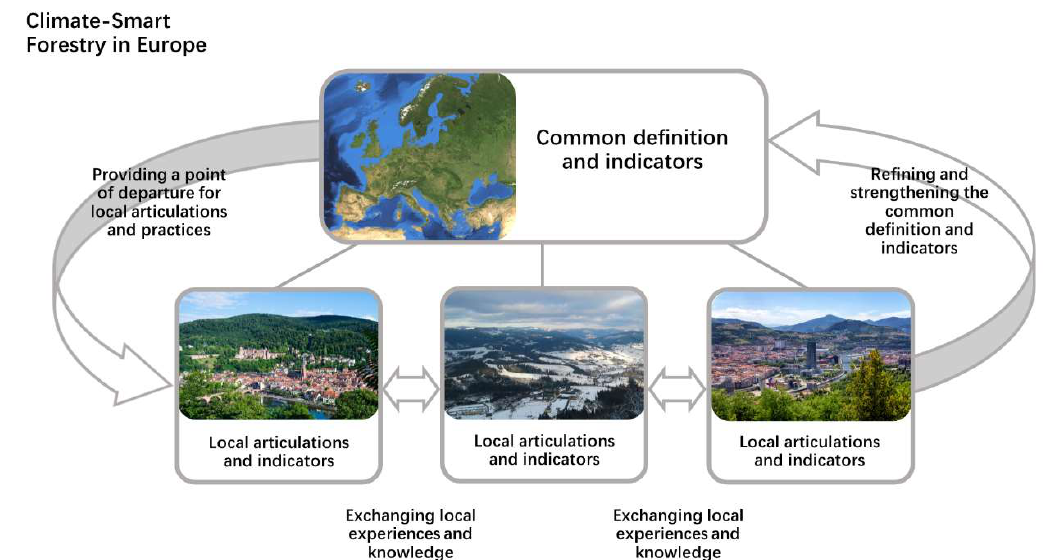
Figure 3. A conceptual figure for how the concept of climate-smart forestry could be used and developed in Europe. The message convened is that a meta-level scientific discussion on common indicators and definitions for climate-smart forestry needs to connect to local articulations and indicators to become applicable in practice and in turn can feed back to the meta-level. Top satellite image from Wikimedia Commons: created by Koyos with NASA WorldWind. Bottom photos from Unsplash (from left to right): by Matteo Krossler, Tetiana Shyshkina, and Yves Alarie.